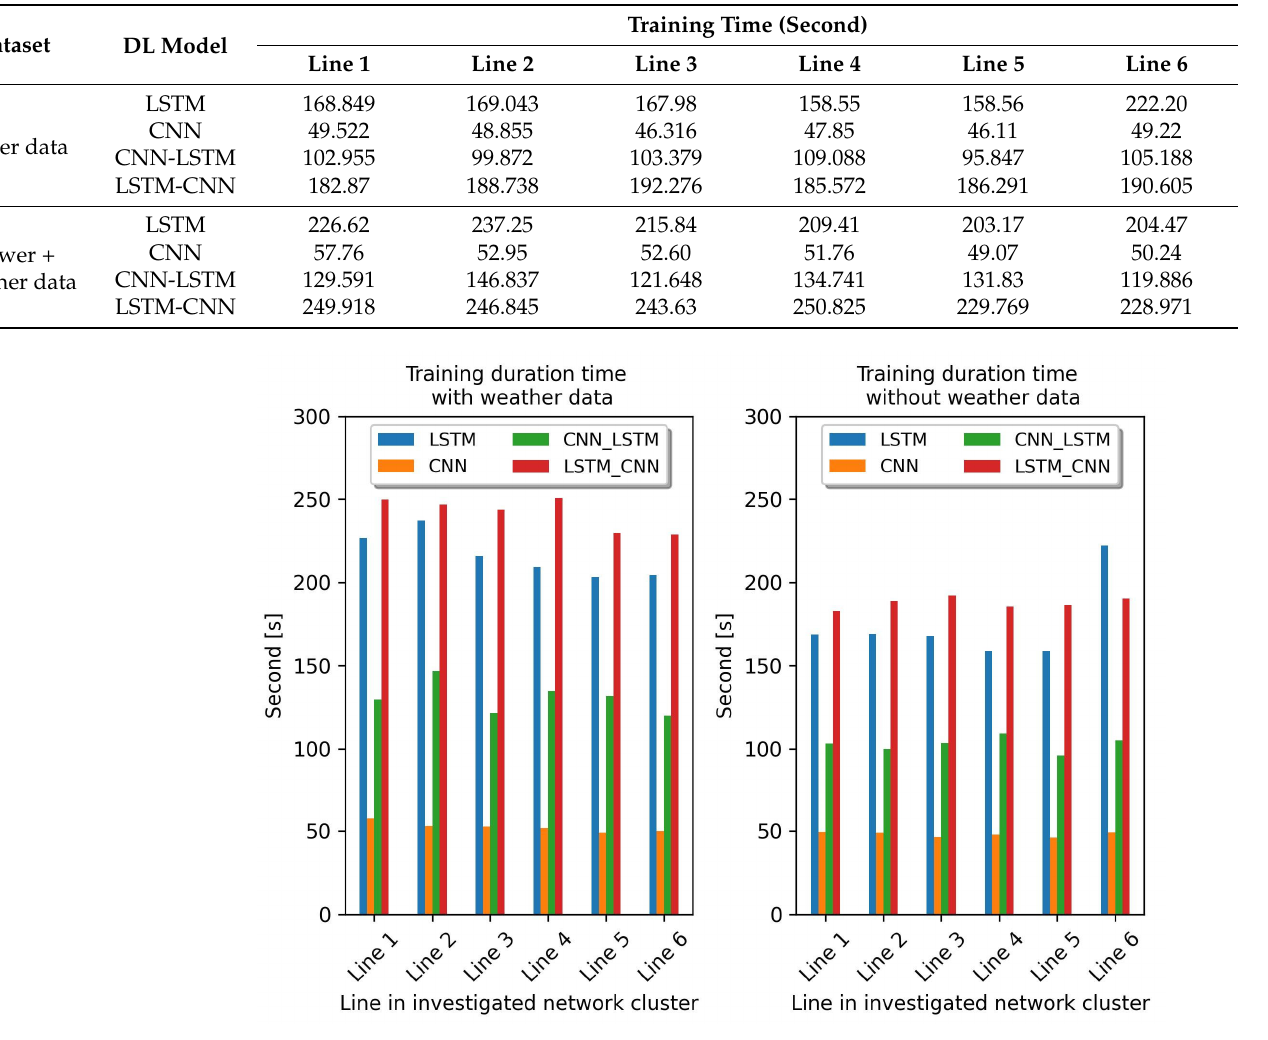
Figure 9. Training duration time of all the deep learning models.